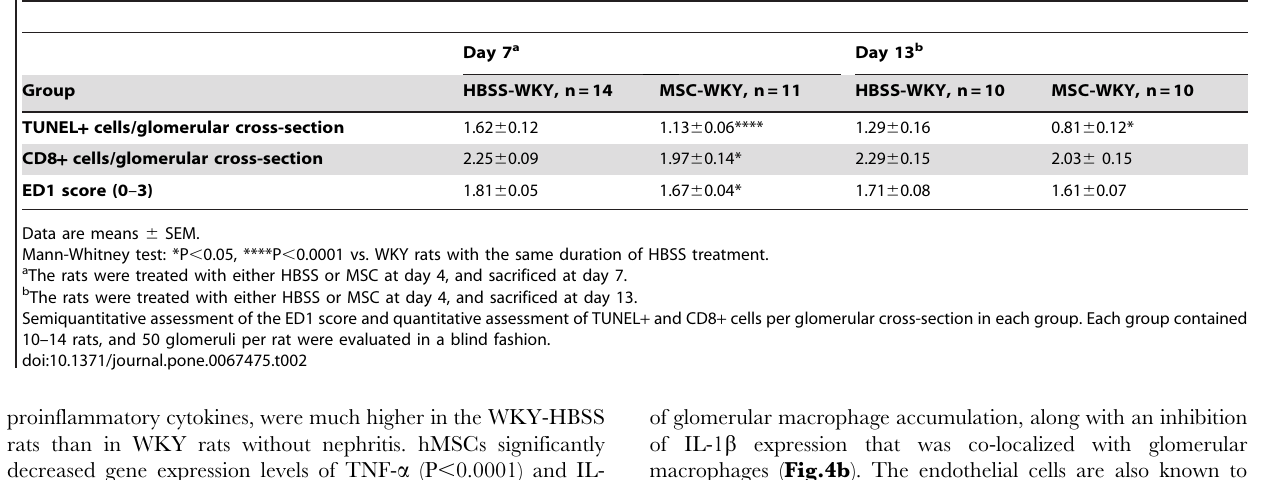
Table 2. Results of immunohistochemistry.